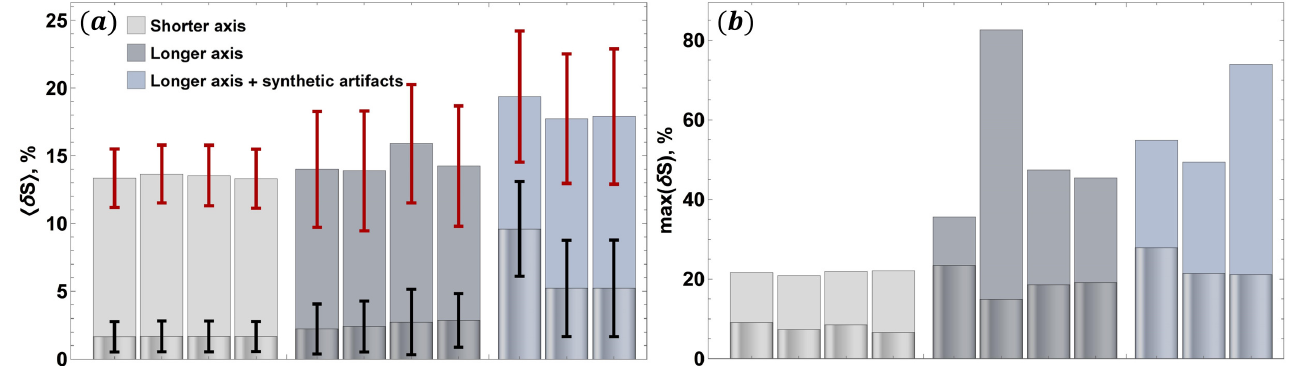
Figure 31. ( a ) Mean and ( b ) maximum δ S values for the cases with a moving reference body. The results for the global and local filtering are represented with matte and glossy bars, respectively.